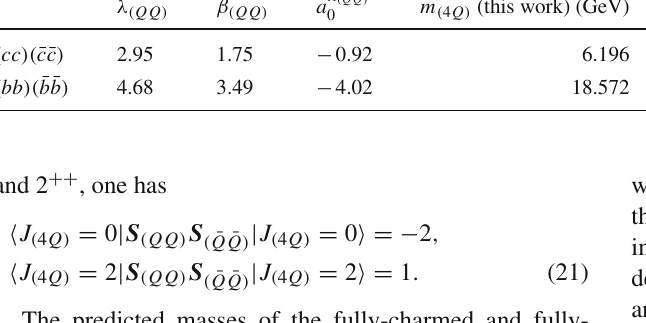
Table 5 Values of various auxiliary parameters and the masses of the fully-charmed and fully-bottomed ( QQ )( ¯ Q ¯ Q ) tetraquarks with J PC = 0 ++ λ ( QQ ) λ ( β ( m ( 4 Q ) (this work) (GeV) m ( 4 Q ) (GeV) QQ ) QQ ) a 0